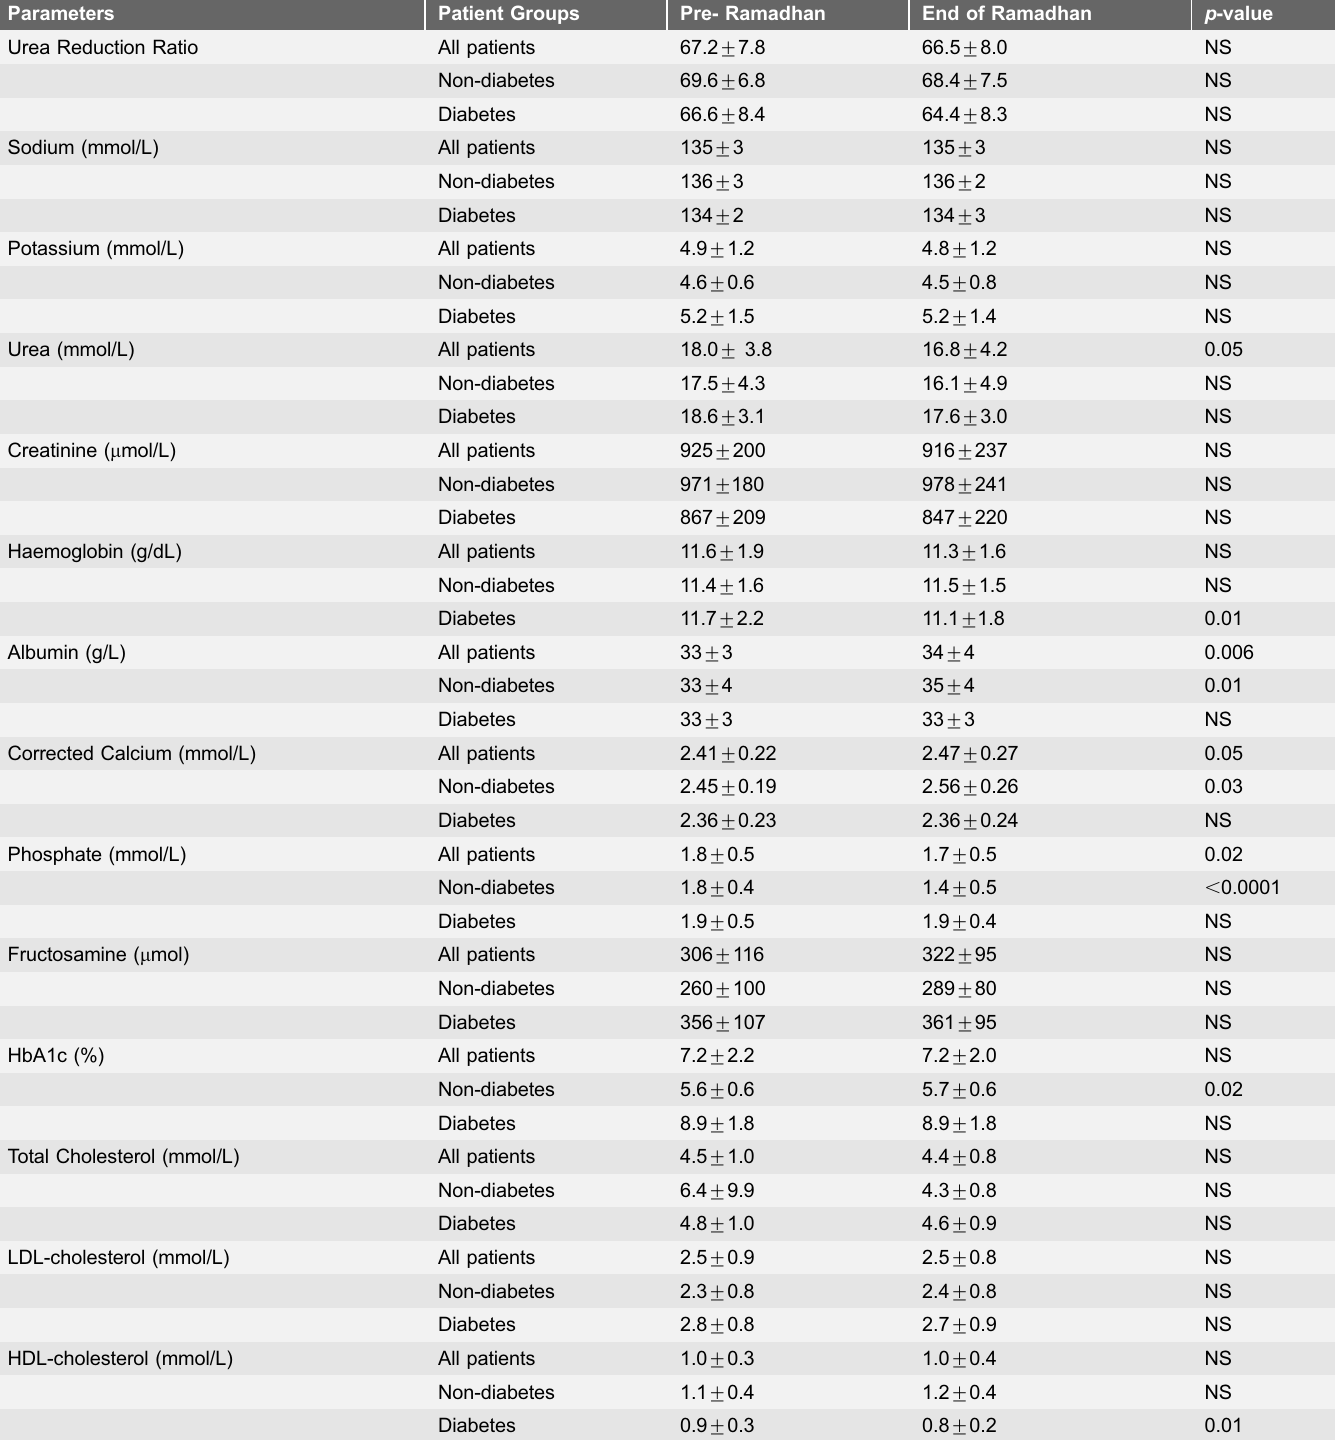
Table 3. Biochemical parameters pre- and end Ramadan fasting in haemodialysis patients (mean ¡ SD) and the p -values of changes (End-Ramadan - pre Ramadan